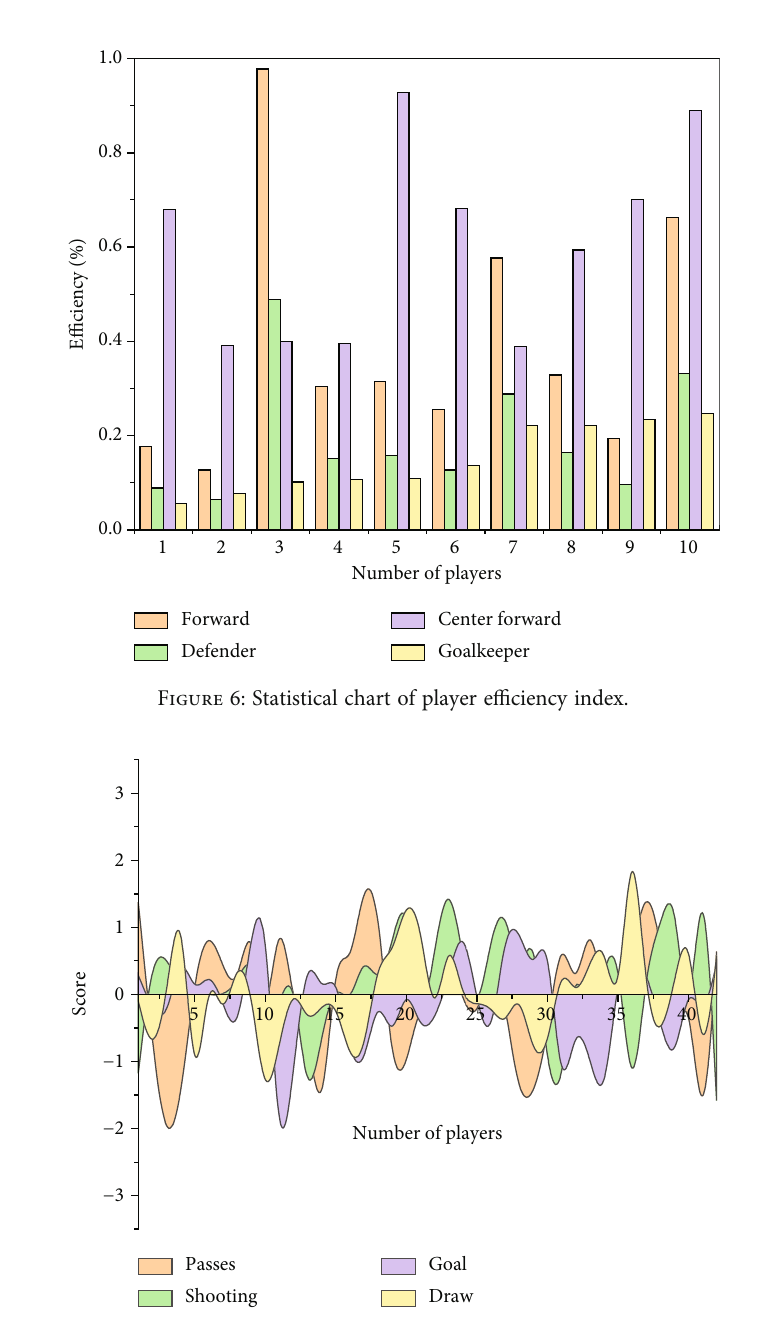
Figure 7: Graph of the results of the analysis of scoring key